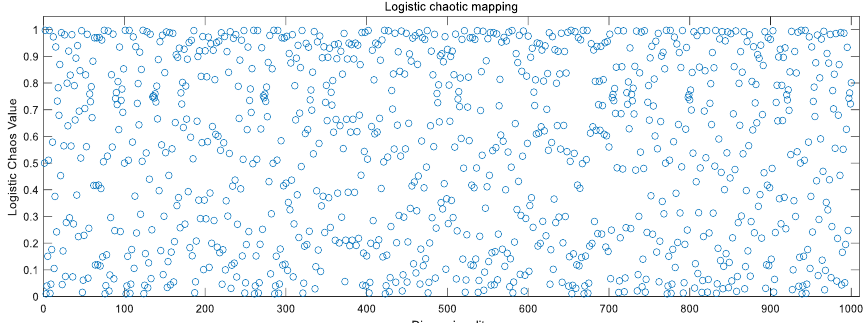
Figure 2. Sine chaotic mapping values.